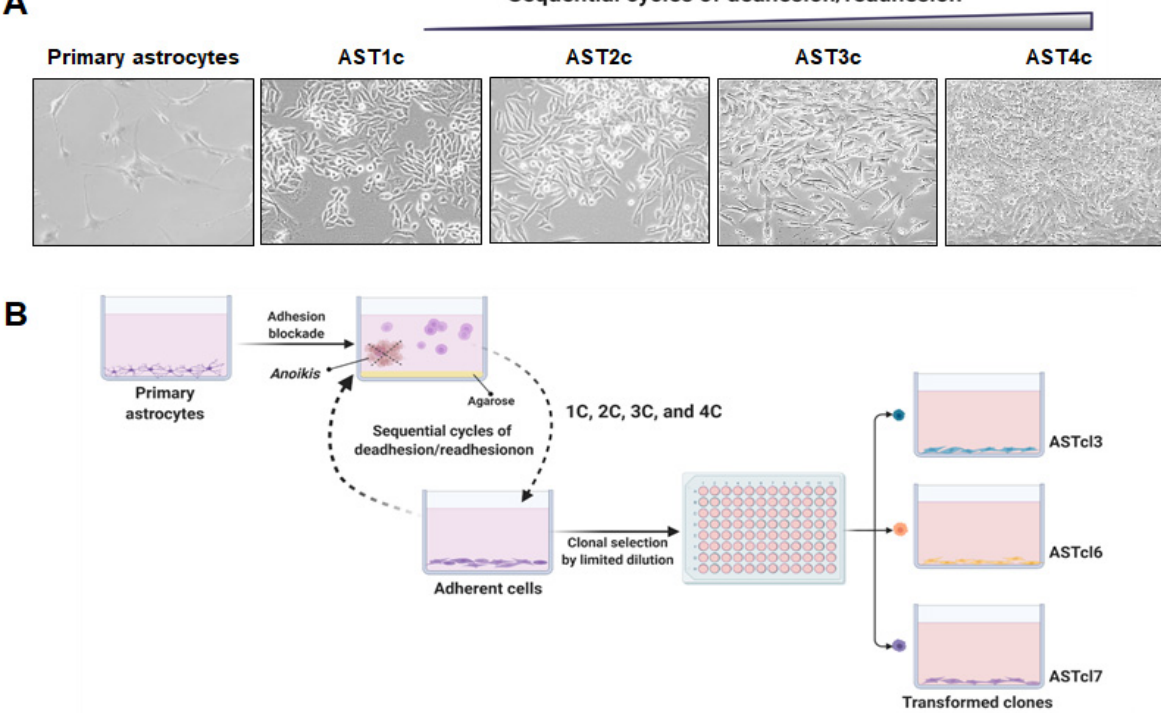
Figure 1. Astrocyte malignant transformation induced by cycles of deadhesion/readhesion: ( A ) Representative images of primary astrocytes and astrocytes submitted to one (AST1c), two (AST2c), three (AST3c), and four (AST4c) sequential deadhesion/readhesion cycles (magnification of 40×). ( B ) Experimental approach to establish the cellular model of malignant transformation of primary human astrocytes. Primary astrocytes were subjected to sequential cycles of deadhesion/readhesion, and after four cycles the spheroids obtained were plated by limiting dilution in 96-well plates. Different clones were randomly selected, giving rise to three distinct clones, denoted ASTcl3, ASTcl6, and ASTcl7. Figure created with BioRender.